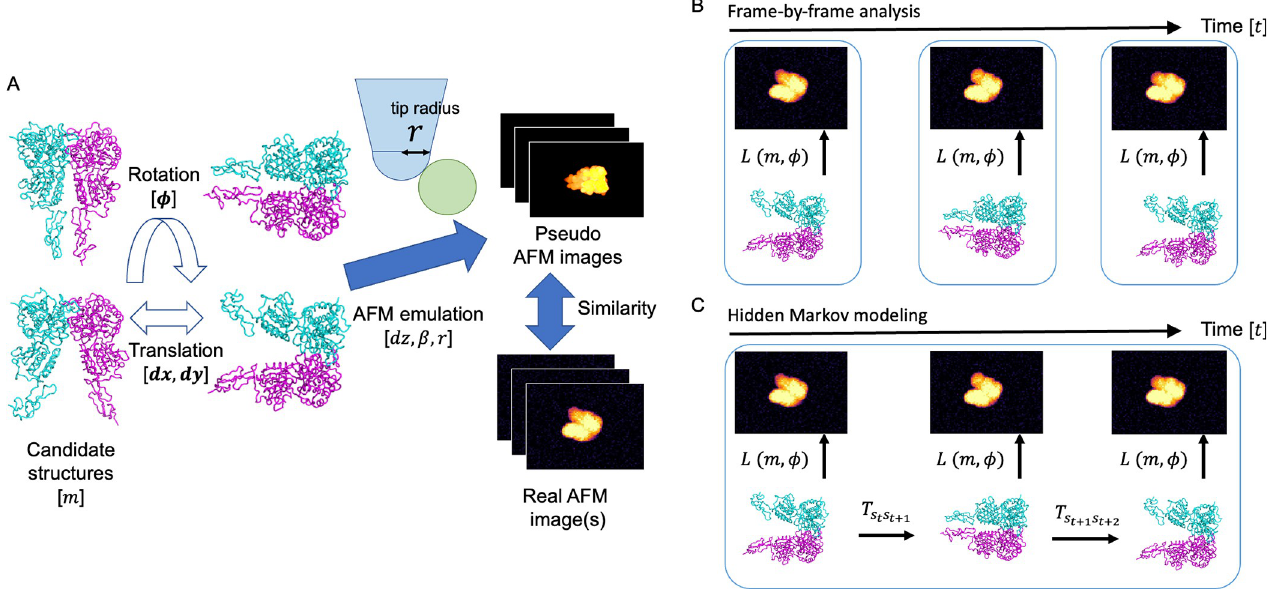
Fig 1. Scheme of analysis on atomic force microscopy images. (A) Computation of likelihood of each atomic force microcopy image. A structure is rotated and translated, and then emulated to generate a pseudo image. The pseudo image is compared with real images with some similarity measures. (B) Schemes of the frame-by-frame rigid body fitting. (C) Schematic of hidden Markov modeling using multiple images as time-series data.